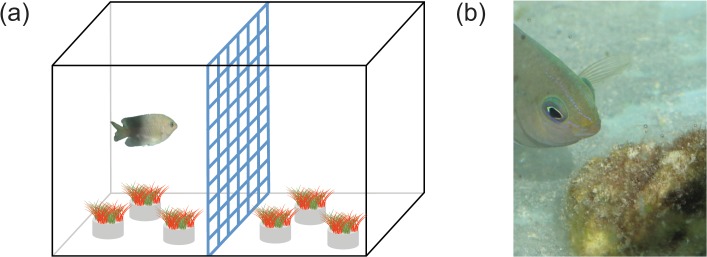
The experimental set-up.(a) Compartmentalization of aquaria (n = 15 aquaria with n = 5 per scenario) and (b) P. wardi with an algal assemblage. Fish were placed into one half of the aquarium with 3 of their algal assemblages. The other half of the aquarium also contained 3 algal assemblages but was fenced off by plastic grating (grate size 1 cm2). The grating was cleaned frequently to allow for efficient exchange of water and nutrients between tank halves which was also aided by one powerhead per aquarium. Photo: D. Bender